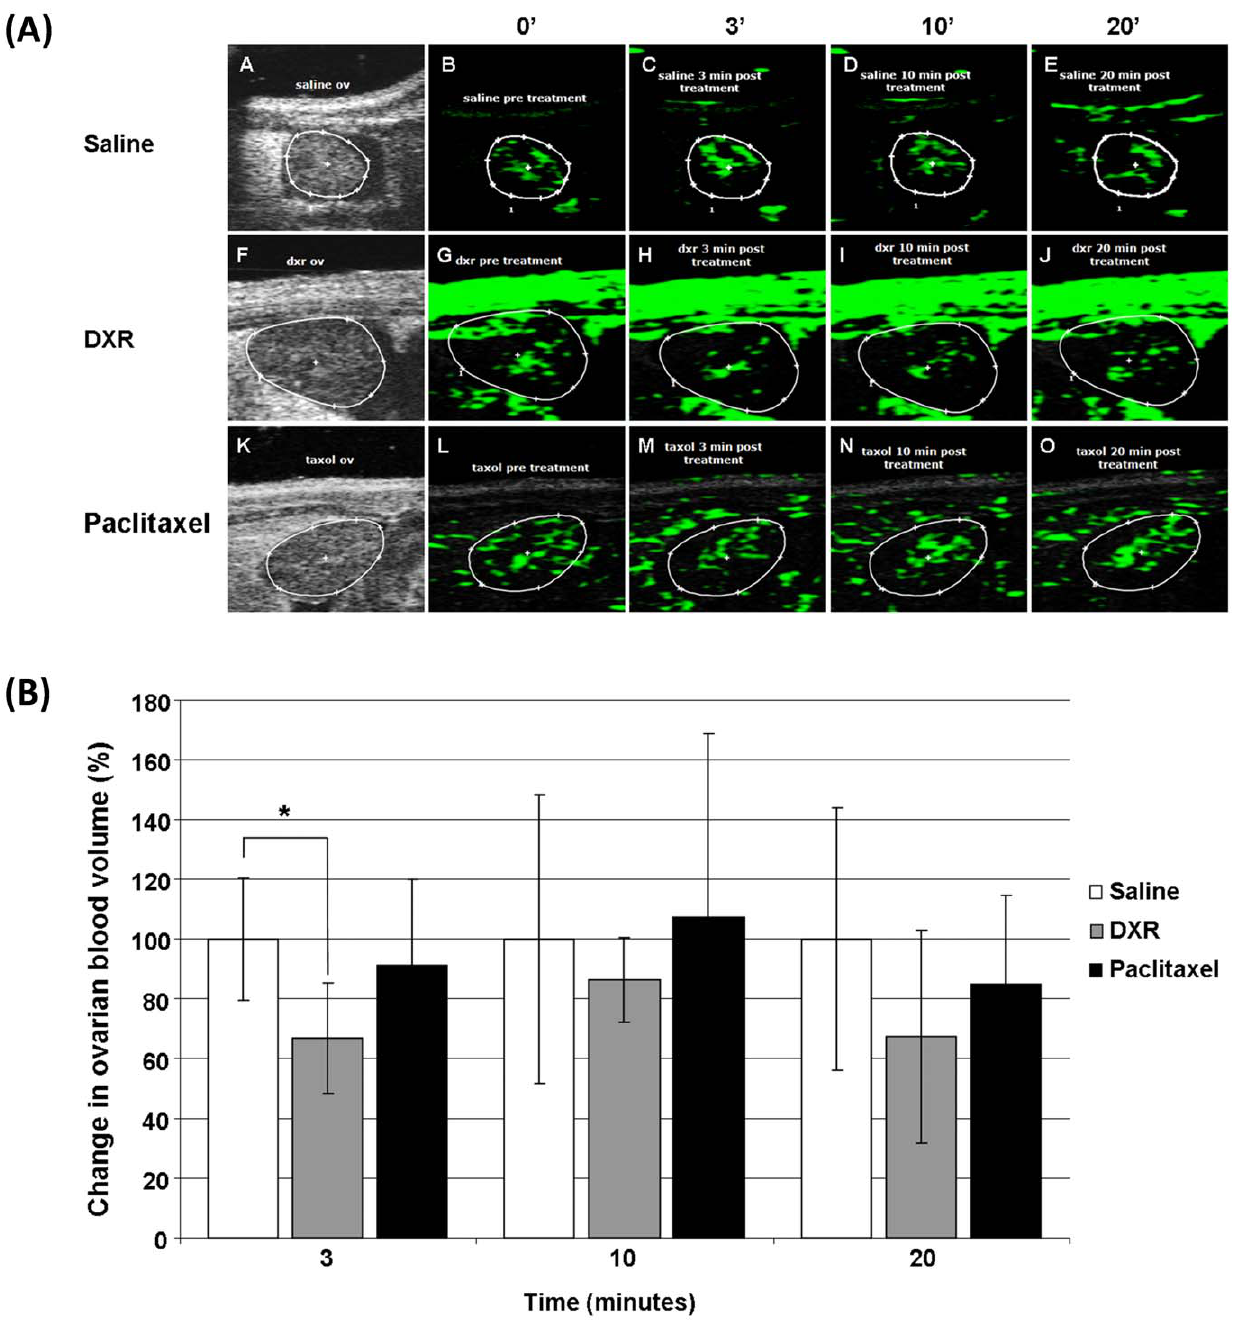
Figure 1. Ultrasound contrast imaging of the ovarian blood volume. A. Representatives images of analyzed microbubbles contrast agent intensity performed at a fixed region of interest (ROI). The Vevo ultrasound depicted a detailed imaging of the blood volume of mouse ovary before and following administration of either saline (a–e) doxorubicin (f–j) or paclitaxel (k–o). Anatomy of the ovary in contrast mode (a,f,k); analysis of contrast agent intensity determined using the appropriate VisualSonics software (b–e, g–j, l–o). The green colors indicate the presence of an enhanced contrast agent). Baseline ovary blood volume (pre-treatment; b,g,l). Ovary blood volume 3 minutes (c,h,m), 10 minutes (d,i,n) and 20 minutes (e,j,o) following the IV injection of either chemotherapy or saline. B. Graphic representation of ovarian blood volume 3, 10 and 20 minutes after doxorubicin (n=7), Paclitaxel (n=8) or saline (n=7) injection indicating a decrease in ovarian blood volume of doxorubicin treated mice (* P , 0.01). Saline-injected mice were standardized to 100% as a reference to chemotherapy-injected mice. Results are presented as mean 6 SD. The data obtained from the images as presented in A, was presented as an Excell curve provided by the VisualSonics software. doi:10.1371/journal.pone.0023492.g001 barrier trait [26,27]. Few ex vivo studies have explored the effect of acetylcholine or adenosine was observed in rabbit and rat models doxorubicin on tissues excised from doxorubicin-injected animals. with doxorubicin–induced cardiomyopathy [5,28]. Brachial artery An impaired endothelial-dependent vasodilatory response to reactivity, a marker for endothelial vasodilatation function,